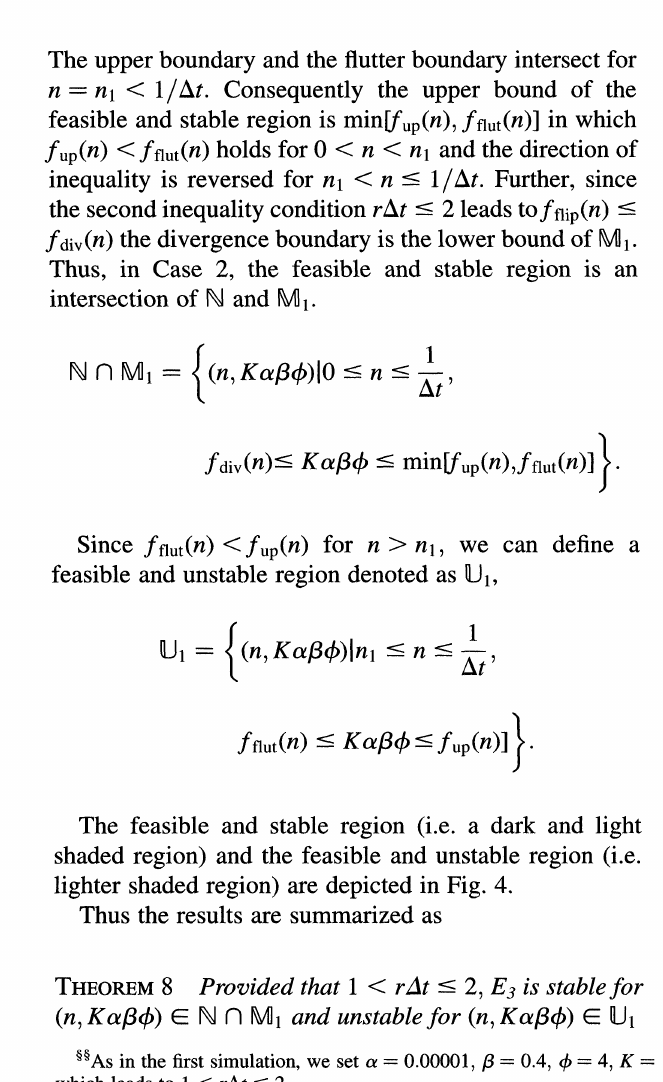
FIGURE 3 Numerical simulation of Easter Island